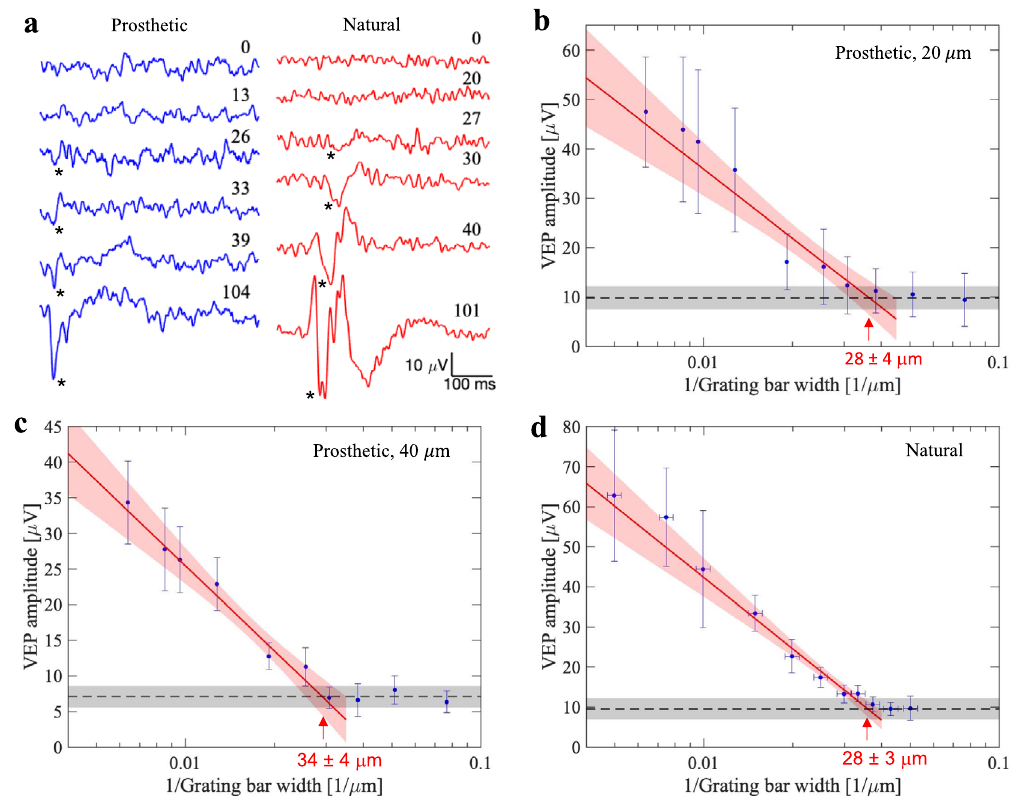
Fig. 7 | Prosthetic and natural visual acuity in rats. a Example VEP waveforms in responsetoalternatinggratingsinRCSrats(blue)withimplantsandinLErats(red). Grating bar width in μ m is shown next to each waveform. Asterisk points at the N1 peak. b – d VEPamplitudeasafunctionofthegratingdensity(inunitsoftheinverse bar width, 1/ μ m) for prosthetic vision with 20 μ m pixels b , 40 μ m pixels c , and for naturalvision d .Theerrorbarsrepresentthestandarddeviationscenteredatmean values,whicharederived from n =5 b , n =4 c ,and n =6 d biologicallyindependent animals, respectively. The vertical error bars indicate the standard deviations